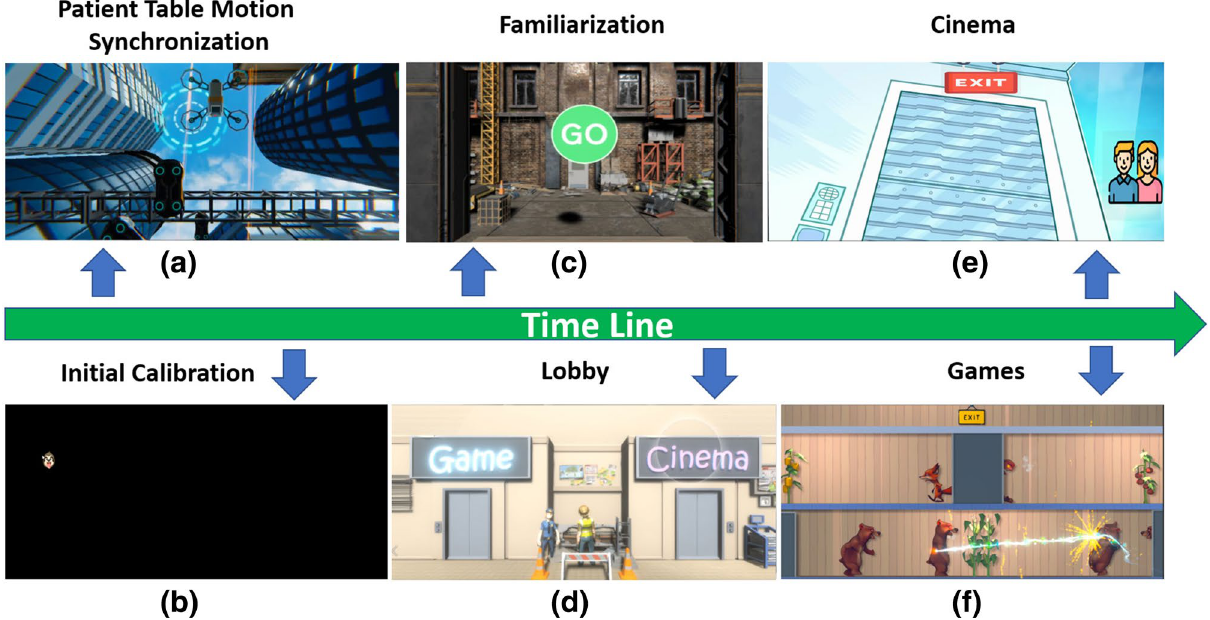
Figure 5. System timeline and content overview: ( a ) opening scene with frame of reference that moves to match what the subject perceives as the patient table is moved into the scanner. ( b ) Once the subject is inside the bore, the eye tracking calibration begins. ( c ) A familiarization scene follows to enhance the gaze tracking by progressive calibration. ( d ) The subject is guided into a VR lobby to select movies ( e ) and games ( f ) using gaze- based